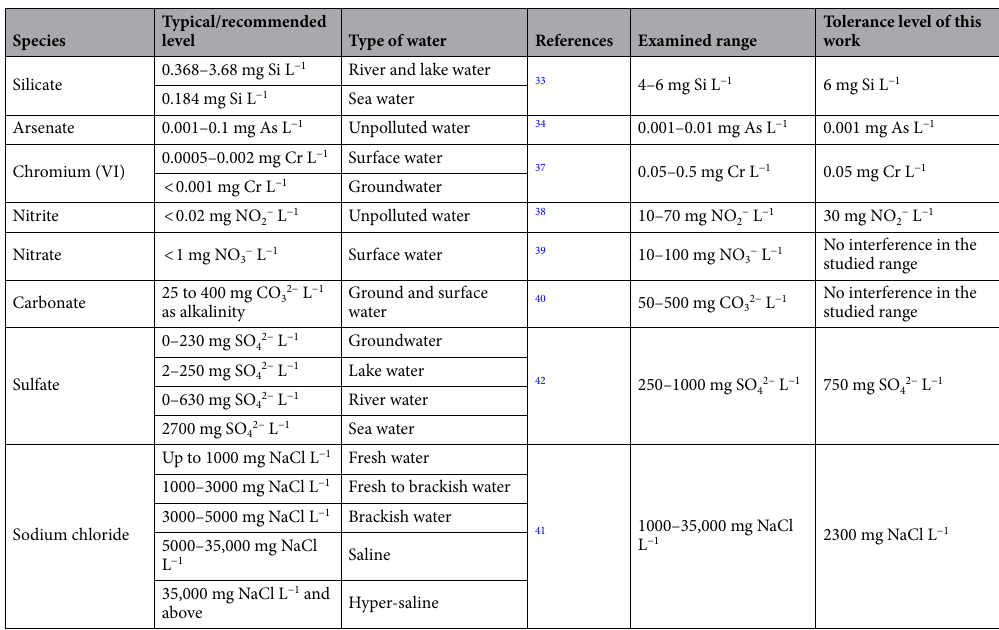
Table 1. Typical and recommended level of the interference species in comparison with tolerance levels analysed by using the proposed